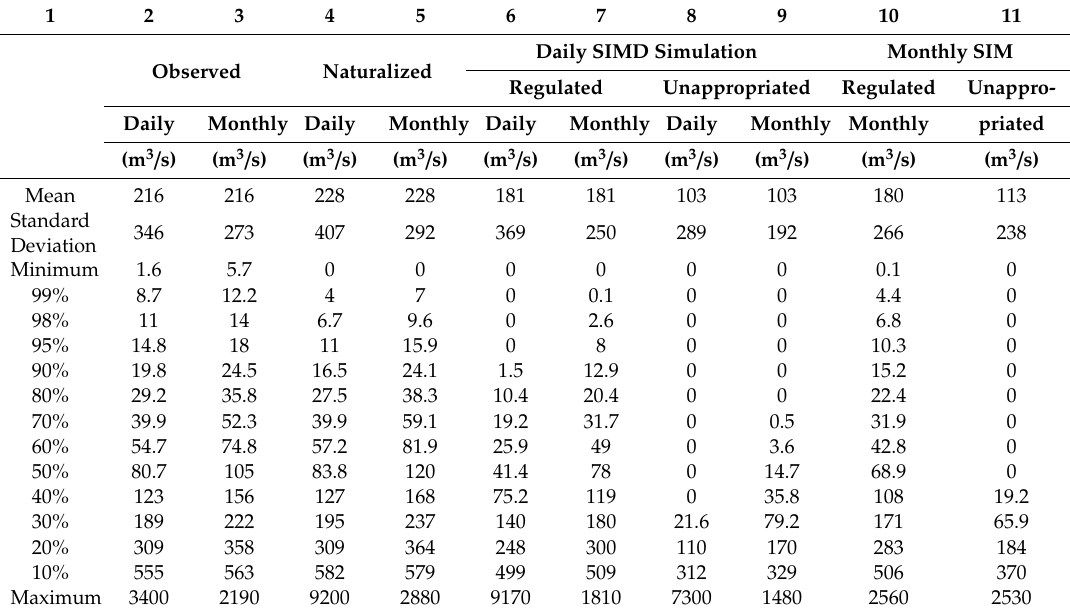
Table 2. Frequency statistics for daily and monthly observed and naturalized flows at the Richmond gauge site and regulated and unappropriated flows from daily and monthly simulations.